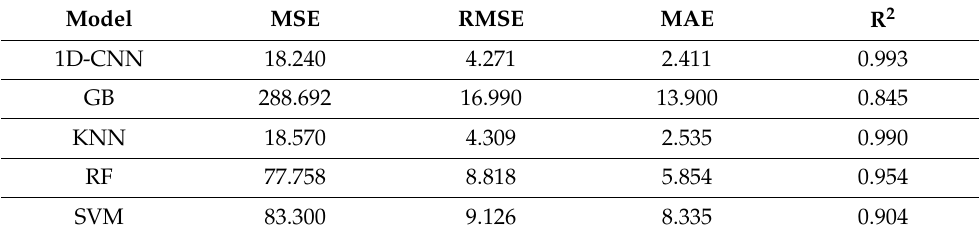
Table 14. Comparative model validation result of the slurry test with RETAINED_PRM as the output.